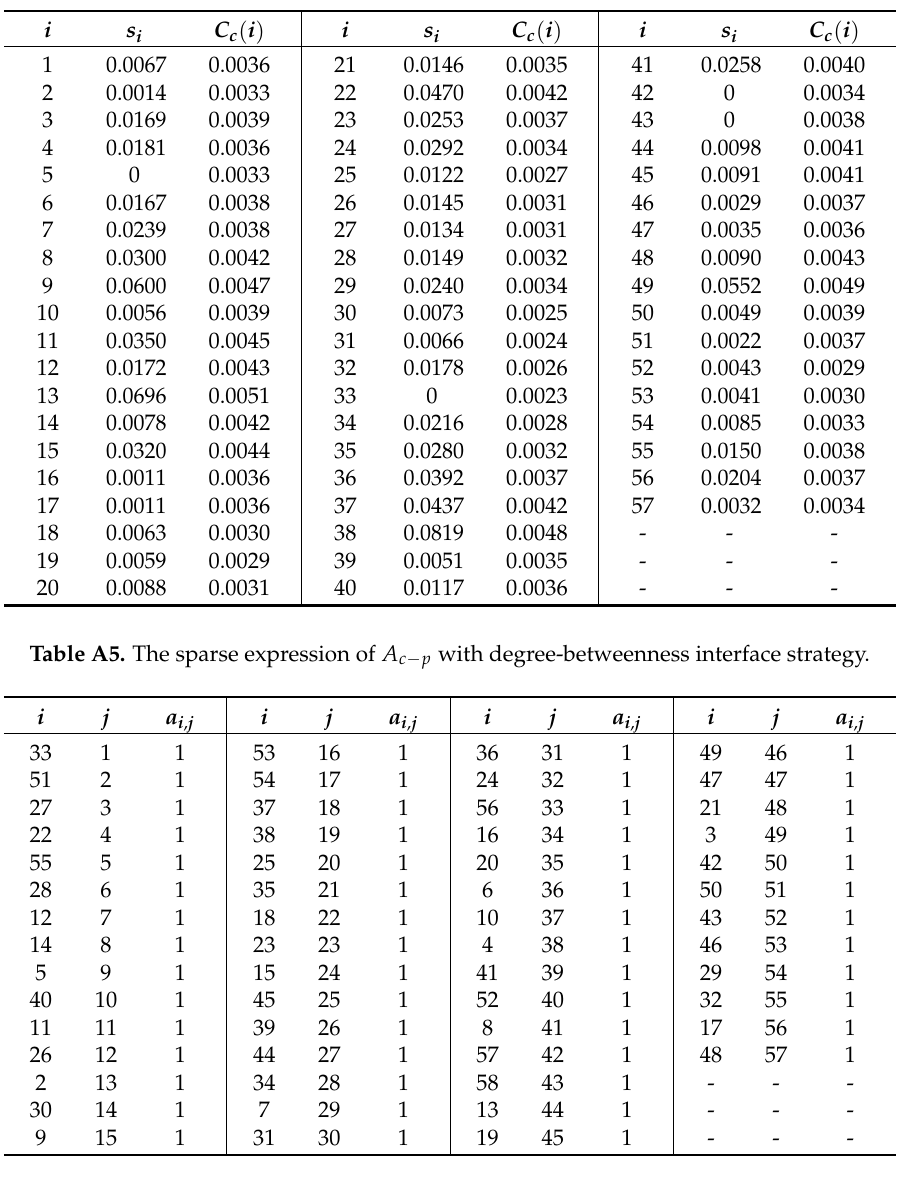
Table A6. The sparse expression of A c − p with closeness centrality interface